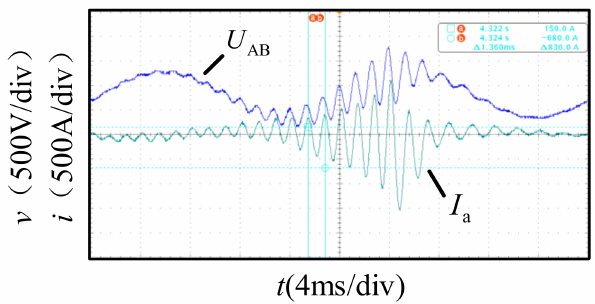
Figure 19. Experimental waveform of two inverters before